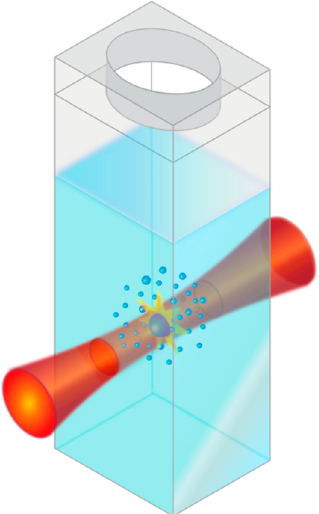
Figure 2. Schematic of the pulsed laser fragmentation in liquid (PLFL) process, where an aqueous solution of ZnO particles is irradiated with a femtosecond IR laser to synthesize smaller ZnO nanoparticles (not to scale) .